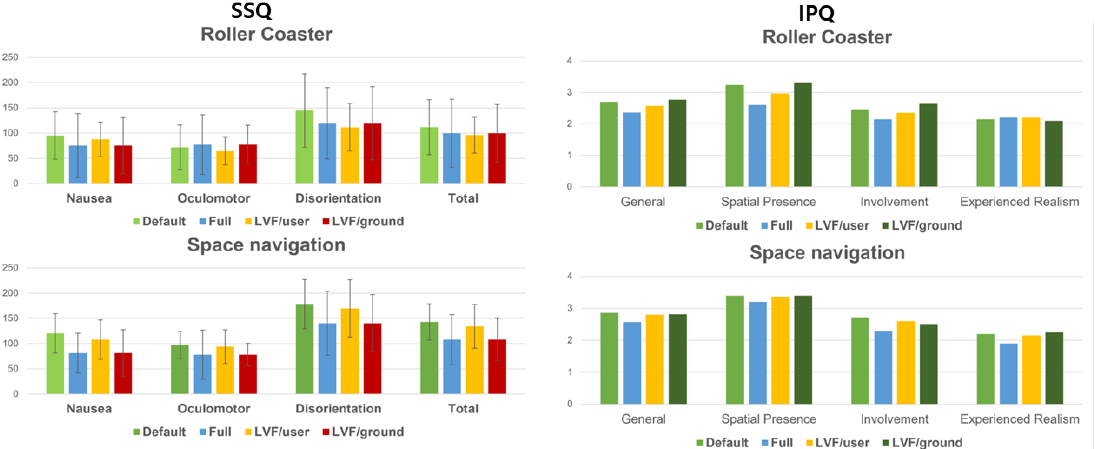
Figure 9. Results of the supplementary experiment with regard to the levels of VR sickness (SSQ score) and user-felt immersion/presence (IPQ